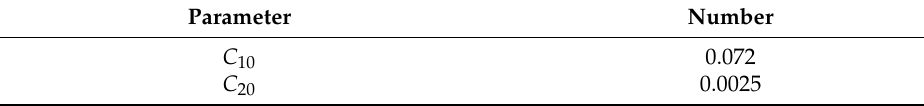
Table 2. Yeoh model parameters.